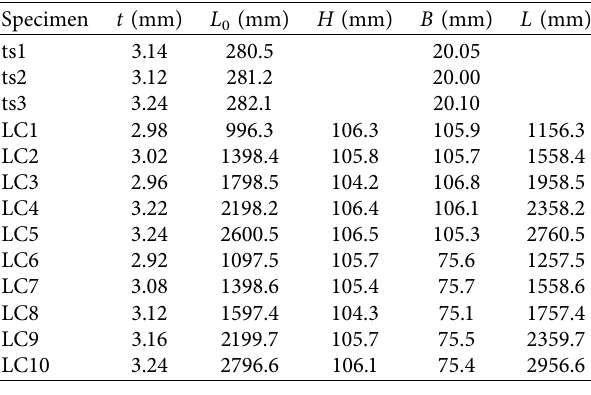
Table 1: Measured dimensions of specimens.